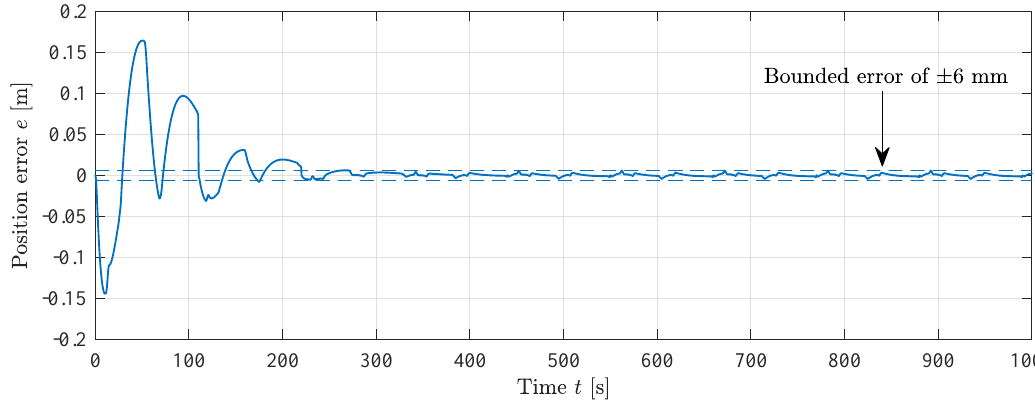
Figure 16. Cylinder position error during MIT-rule feedforward simulation, γ = 200 s · m − 3 .